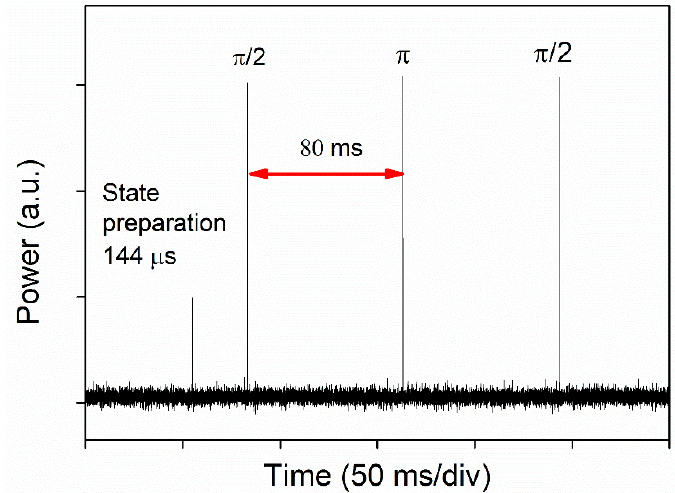
Figure 7. Scheme of the power stabilization system of Raman-laser pulse.